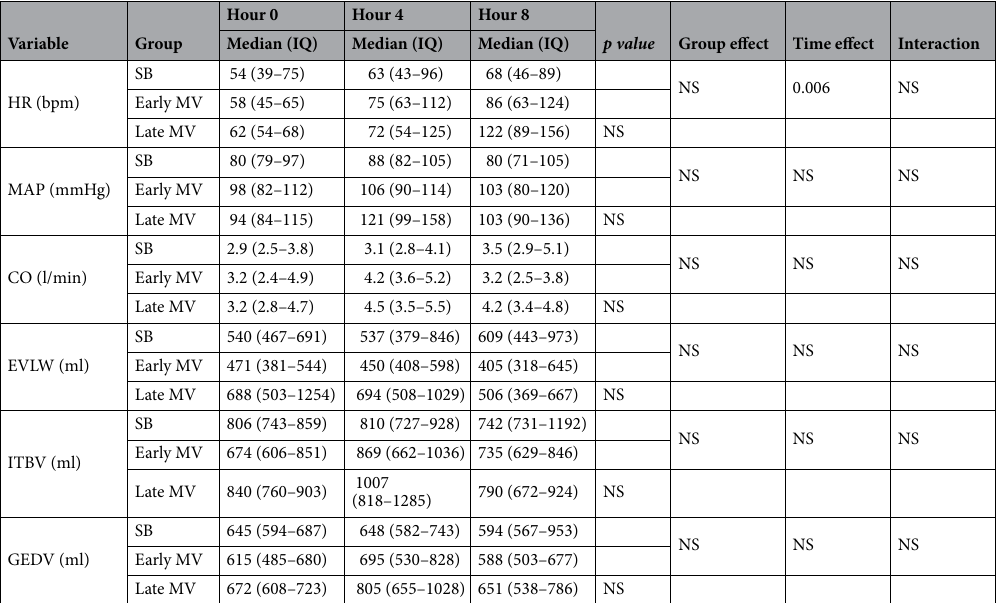
Table 2. Hemodynamic parameters. p value corresponds to Friedman test to the Late MV group, (*) correspond to p < 0.05 for multiple comparisons. The interaction, group effect, and time effect were estimated between SB and Early MV groups, using the GLMM regarding the combined effects of time and ventilatory strategy over each variable. The uppercases * and ◊, denote Tukey test for comparing variables over time in case of the interaction was present. MV mechanical ventilation, SB spontaneous breathing, HR heart rate, MAP median arterial pressure, CO cardiac output, EVLW extravascular lung water, ITBV intrathoracic blood volume, GEDV global end diastolic